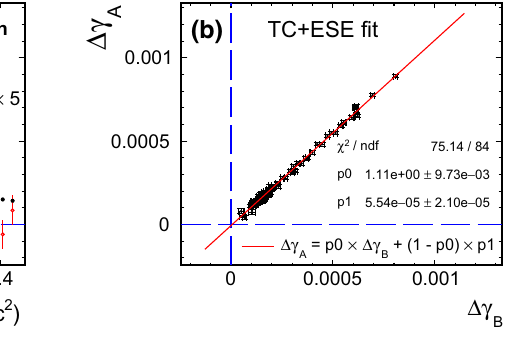
Fig. 4 Toy model simulation of ( a ) inclusive (cid:2)γ and (cid:2)γ A − (cid:2)γ B as functions of m inv , and b (cid:2)γ A versus (cid:2)γ B . The simulation corresponds to the 40–50% centrality Au+Au collisions at